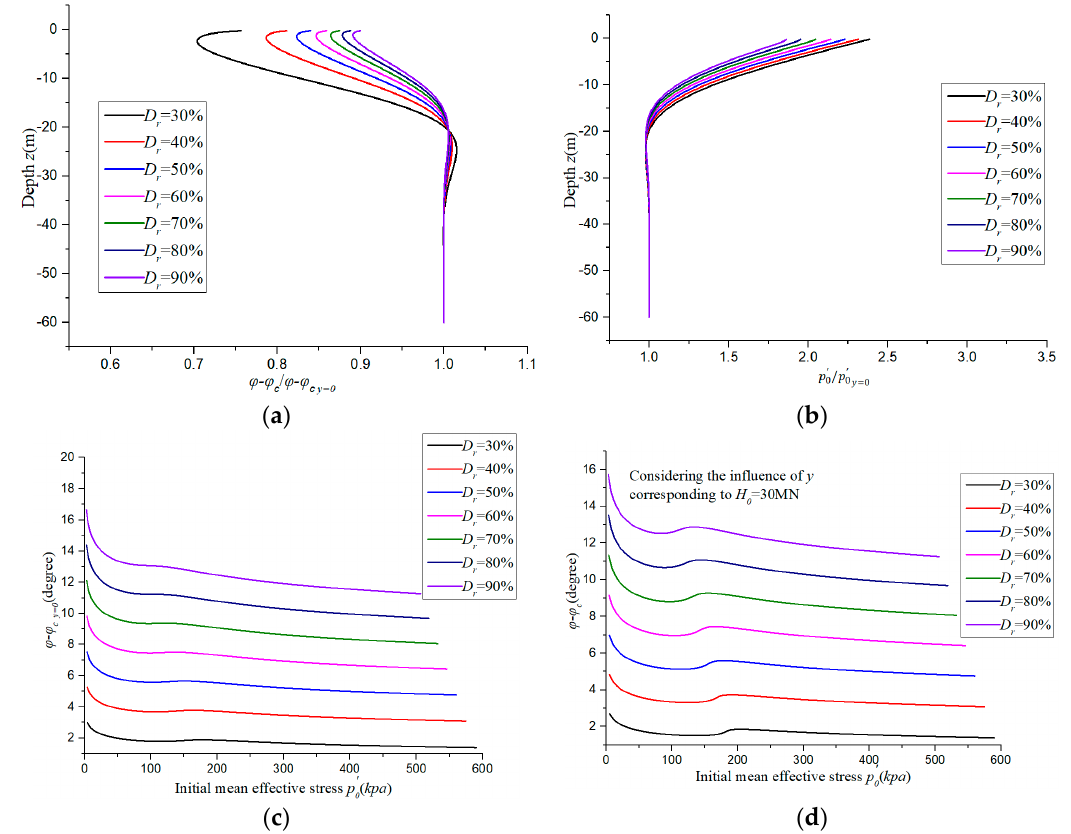
Figure 13. The in fl uence of relative density 𝐷 (cid:3045) on mean e ff ective stress-internal friction angle state Figure 13. The influence of relative density D r on mean effective stress-internal friction angle state of of sand: ( a ) 𝜑 − 𝜑 (cid:3030) /𝜑 − 𝜑 (cid:3030)(cid:3052) at di ff erent depths; ( b ) 𝑝 (cid:2868)(cid:4593) /𝑝 (cid:2868)(cid:4593) at di ff erent depths; ( c ) The rela- (cid:2880) (cid:2868) (cid:3052) (cid:2880) (cid:2868) sand: ( a ) ϕ − ϕ c / ϕ − ϕ c at different depths; ( b ) p (cid:48) / p (cid:48) at different depths; ( c ) The relationship 0 0 y = 0 y = 0 tionship between 𝜑 − 𝜑 (cid:3030) and 𝑝 (cid:2868)(cid:4593) (ignoring the in fl uence of 𝑦 ); ( d ) The relationship between 𝜑 − between ϕ − ϕ c and p (cid:48) (ignoring the influence of y ); ( d ) The relationship between ϕ − ϕ c and p (cid:48) 0 0 𝜑 (cid:3030) and 𝑝 (cid:2868)(cid:4593) (considering the in fl uence of 𝑦 ). (considering the influence of y ).